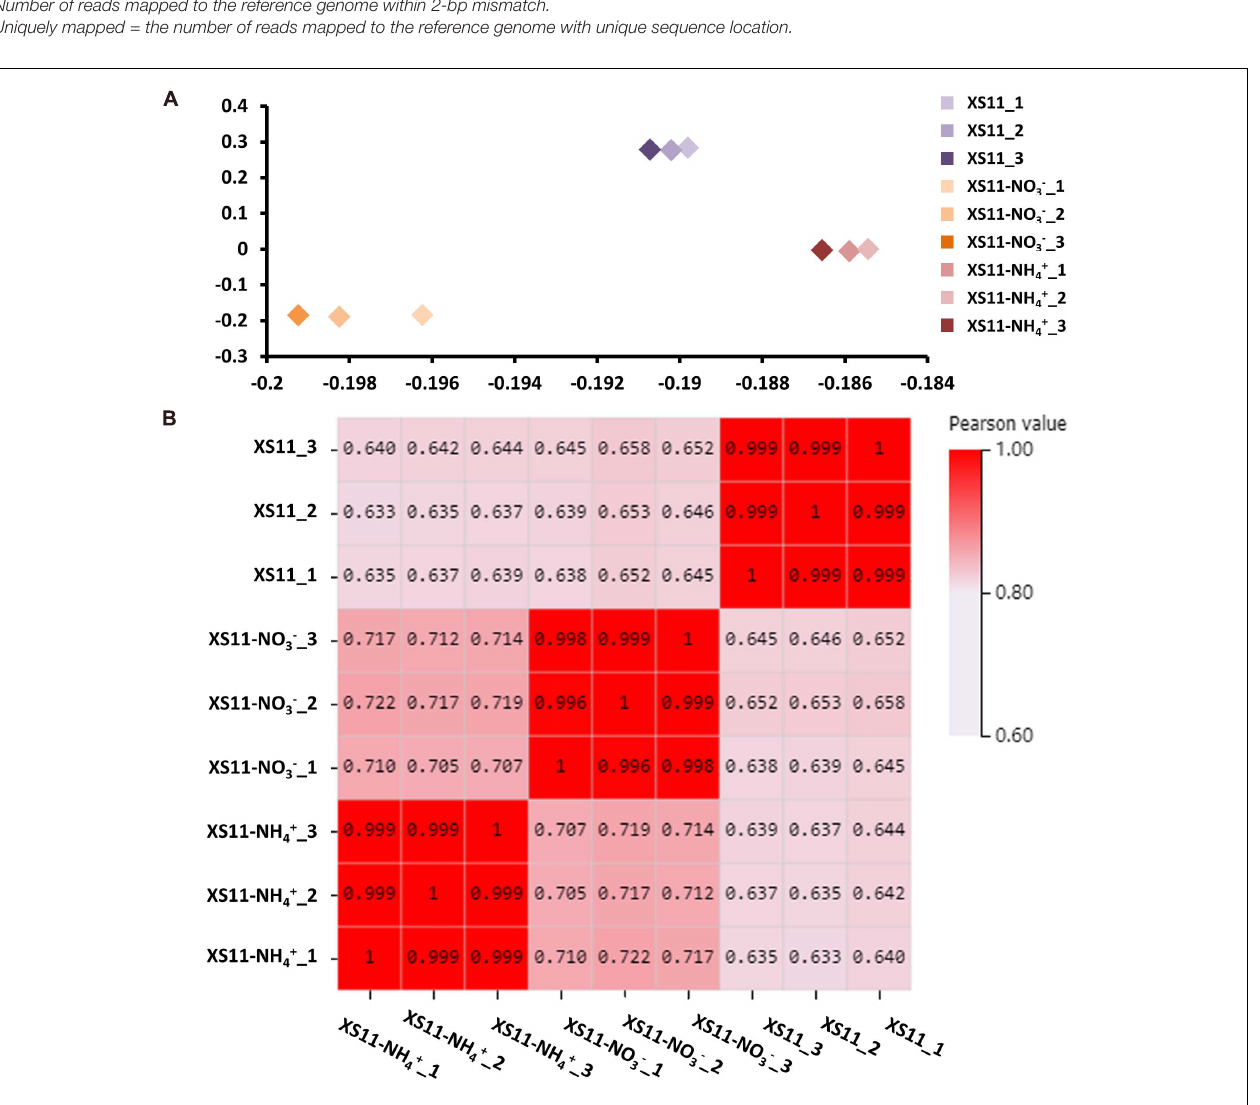
Frontiers in Microbiology |